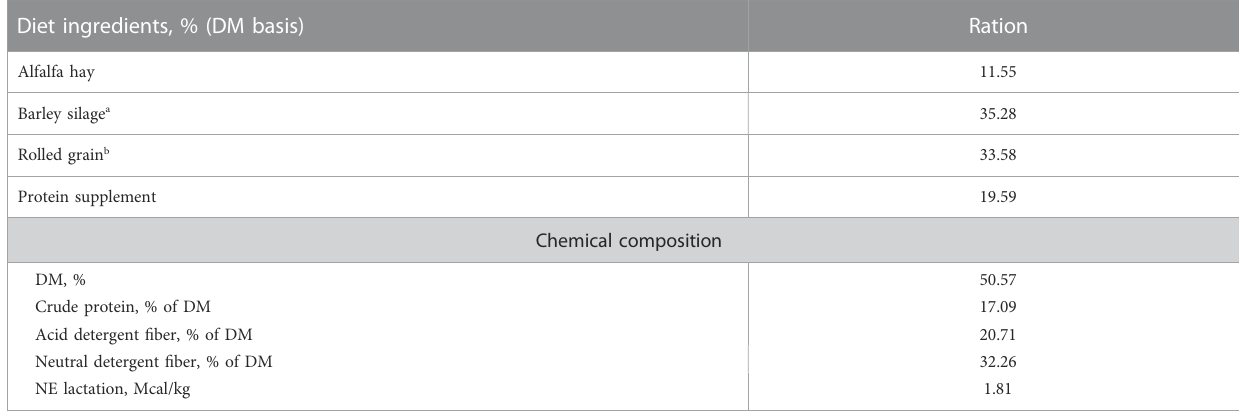
TABLE 1 Diet ingredients and chemical composition of total mixed ration for the study cows. Average values of ingredients and chemical composition are presented. Diet ingredients, % (DM basis) Alfalfa